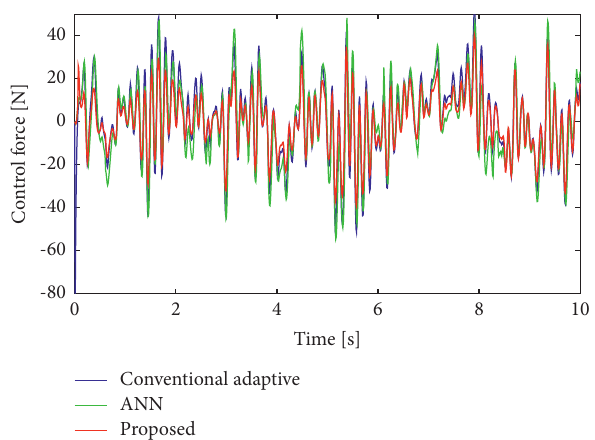
Figure 16: The comparison of control forces for the system for three different strategies.